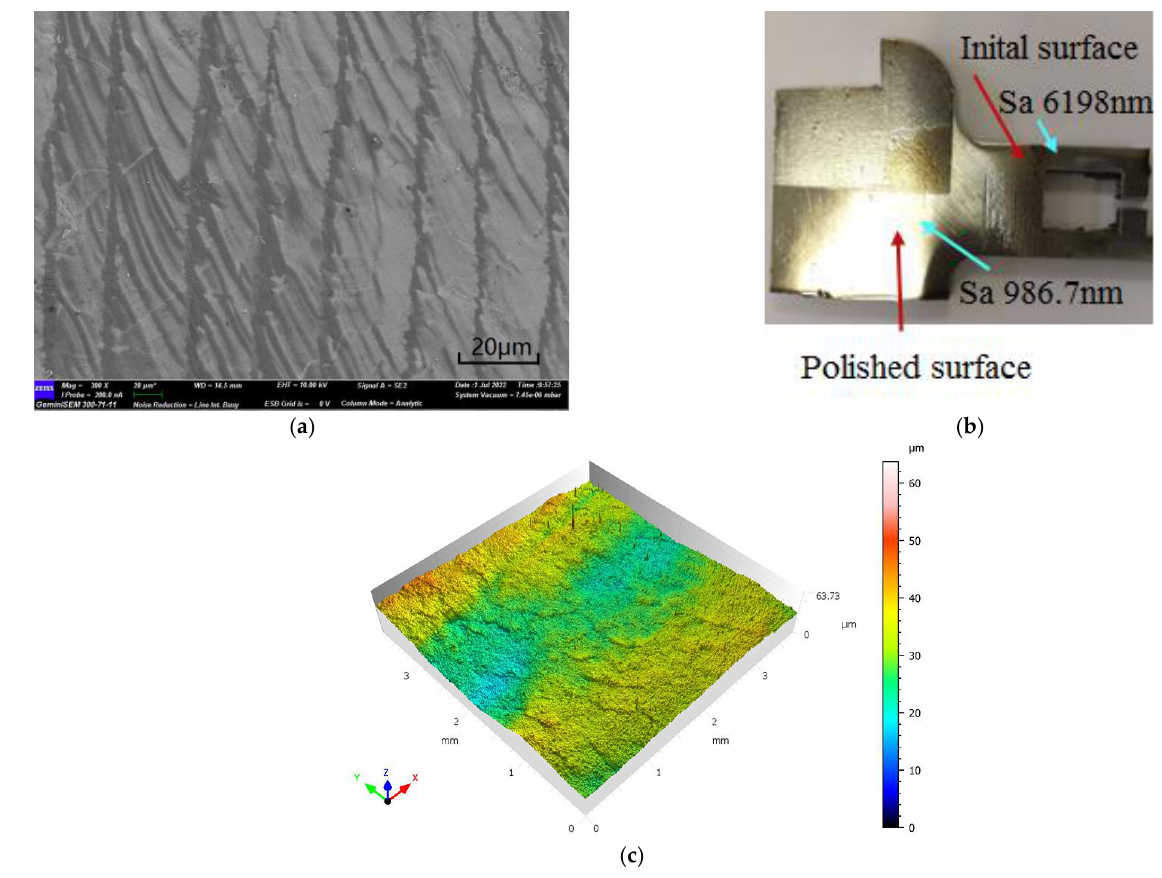
Figure 11. Polished specimen A’ and surface morphology of area A’. ( a ) SEM images of Part A’; ( b ) Polished specimen A’; ( c ) 3D profiles of A’.